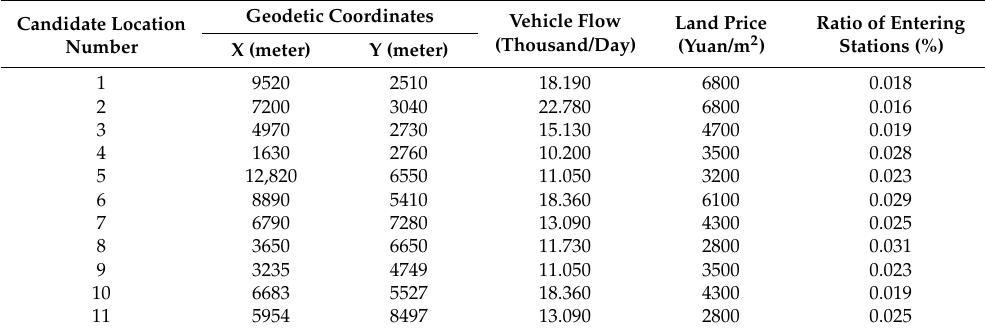
Table 2. The general situation of the candidate